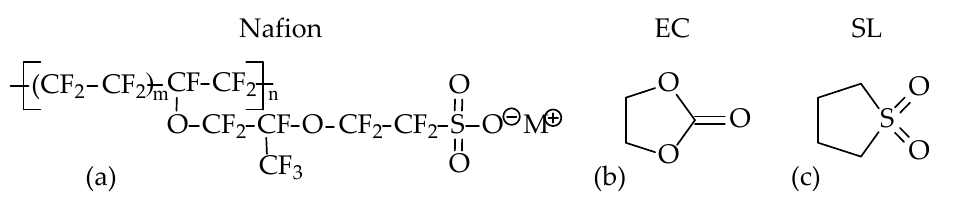
Figure 1. Structural formulas of Li-Nafion (where M + is an exchangeable counterion) ( a ), ethylene carbonate ( b ), and sulfolane ( c ).